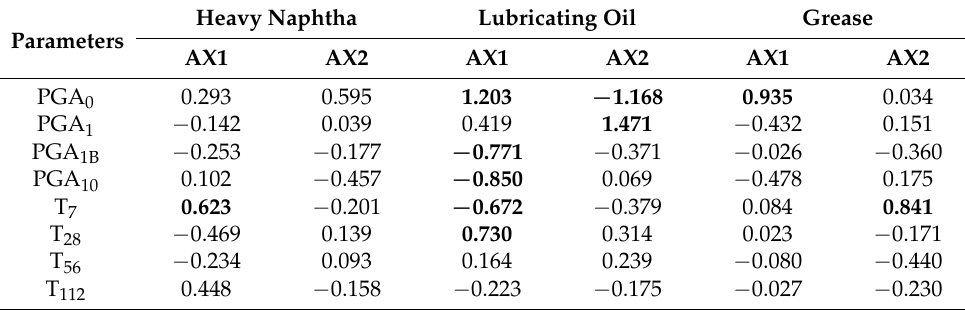
Table 1. Inter set correlations of environmental dummy variables with two first redundancy axes for heavy naphtha, lubricating oil, and grease. PGA treatments: PGA 0 —reference; PGA 1 —1%